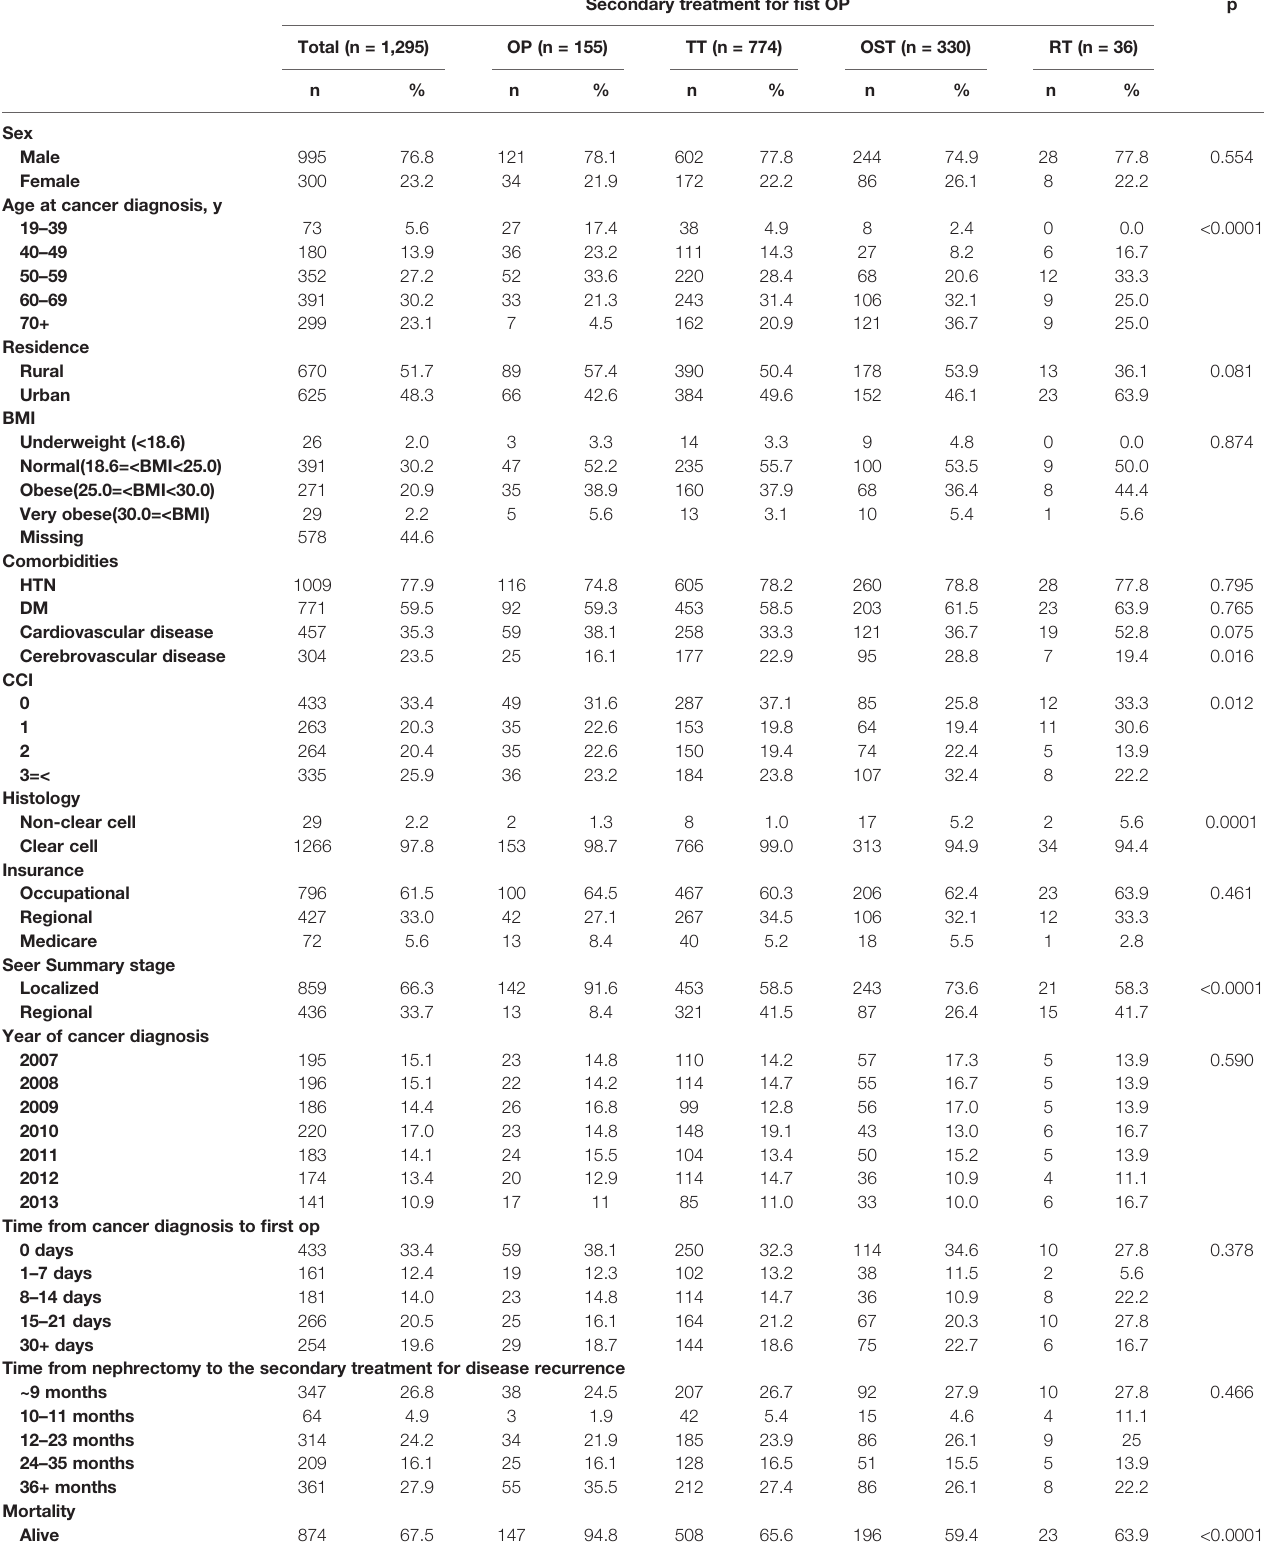
TABLE 1 | Overall patient ’ s baseline demographics according to the therapeutic